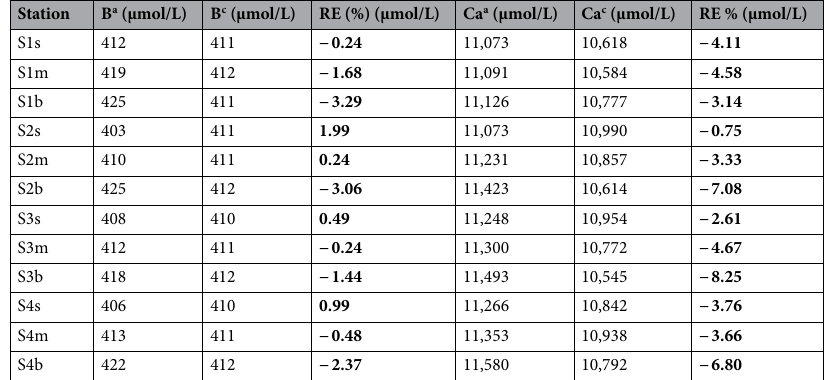
Table 3. Calcium and boron concentrations (µmol/L) in seawater at three depths: surface (s), middle (m), and bottom (b) at the four sampling stations (S1, S2, S3, and S4). The relative error (RE%) assumes the analyzed value as the expected result. B a total analyzed boron, B c total calculated boron (AQM Program), Ca a total analyzed calcium, Ca c total calculated calcium (AQM Program). Significant values are in